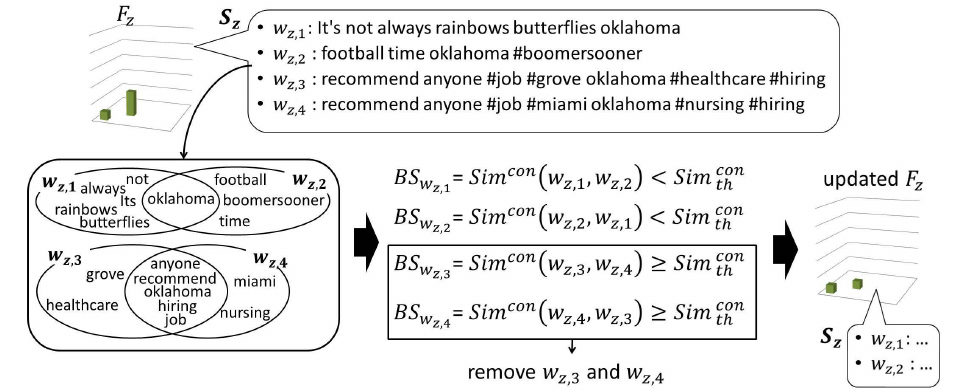
Figure 4. Area-based frequency histogram F z of the word u z is updated by removing the similar tweets from the set of tweets S z in its usage history based on the bot score BS w